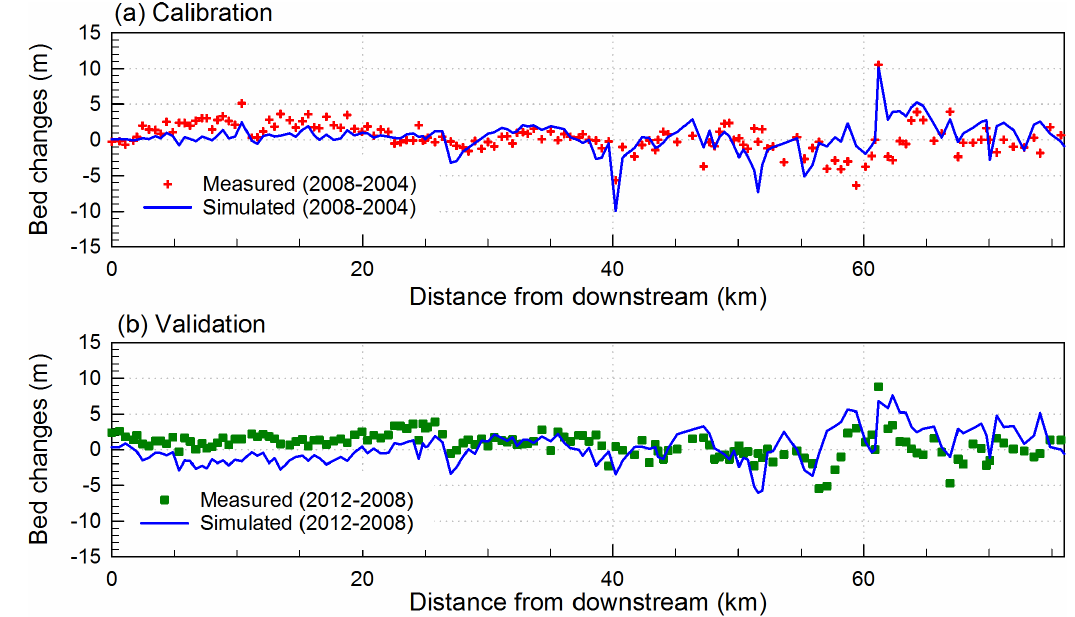
Figure 4. ( a ) Calibration result of the riverbed changes during 2004 – 2008 and ( b ) the validation result of the riverbed changes during 2008 – 2012 using the lowest point of each section along the